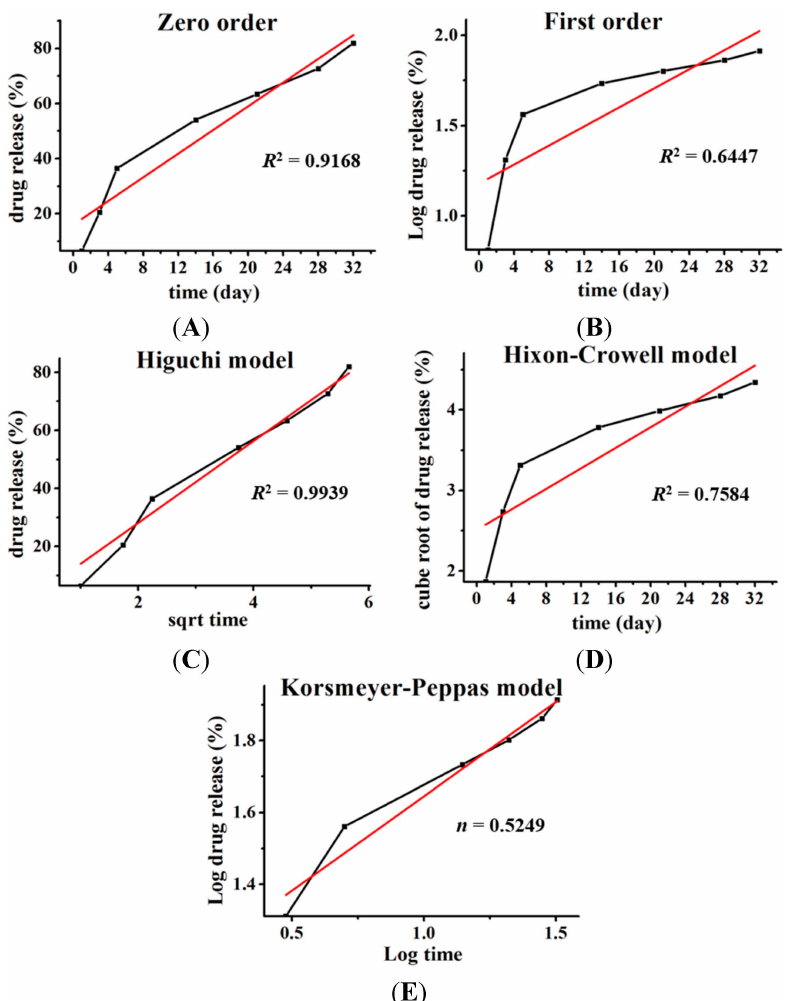
Figure 8. Drug release data fitted to various kinetic models. ( A ) Zero order; ( B ) First order; ( C ) Higuchi model; ( D ) Hixson-Crowell model; and ( E ) Korsmeyer-Peppas